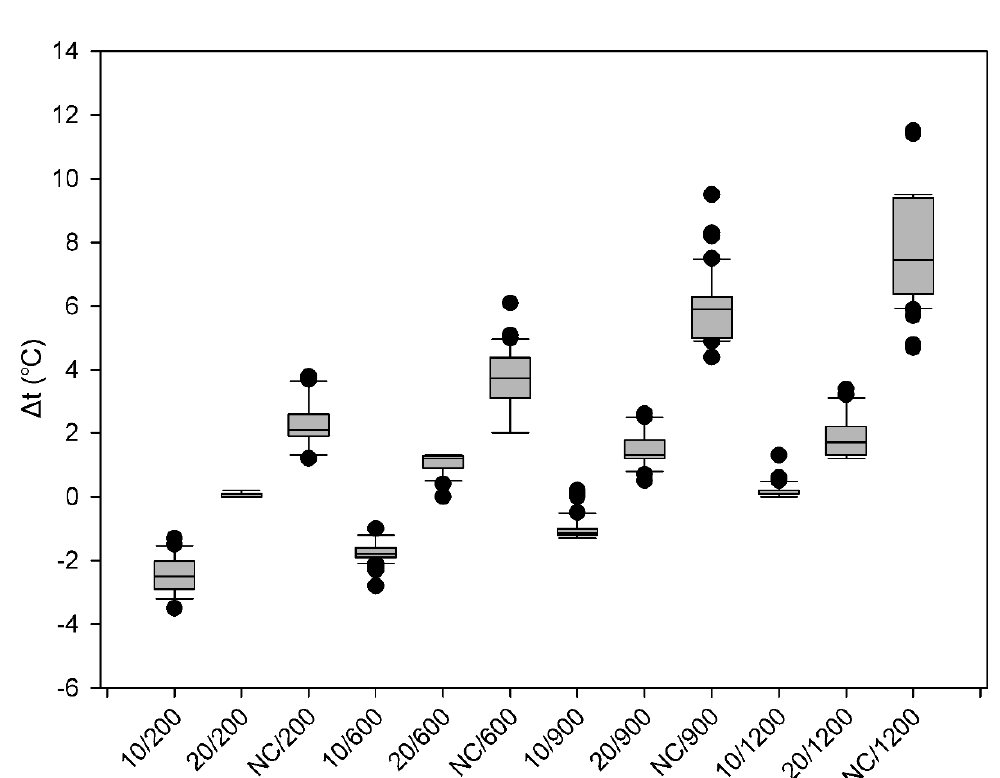
Figure 5. Temperature changes across the study groups. The lower margin of the boxes shows the 25th percentile, the line within the boxes marks the median, and the upper margin of the boxes indicates the 75th percentile. The error bars (whiskers) above and below the boxes indicate the 90th and 10th percentiles. The black dots represent the outliers. Labels of the X -axis: temperature of cooling fluid (°C)/rpm; NC: no cooling.